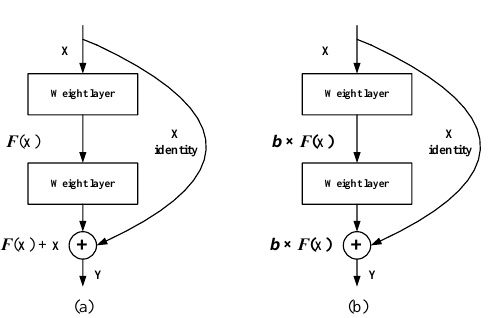
Figure 6. Two different residual blocks. ( a ) A typical residual module. ( b ) A residual module with stochastic depth.